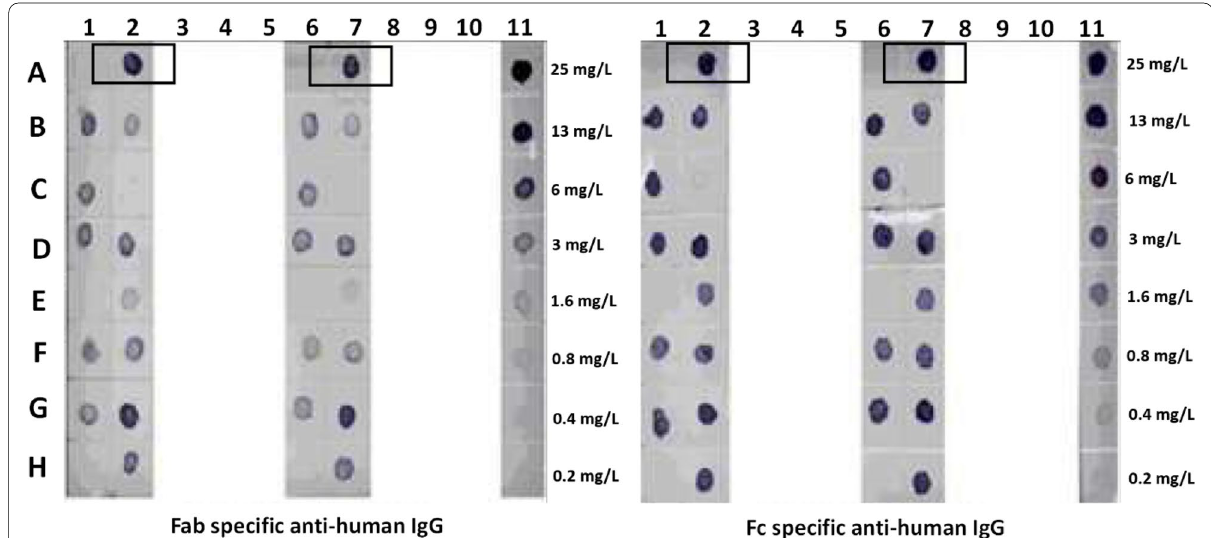
Fig. 2 Dot blot analysis showing the best performing H3F9 (A2 and A7) clone that exhibited higher expression of anti-CD20 antibody was chosen and subcloned for shake flask